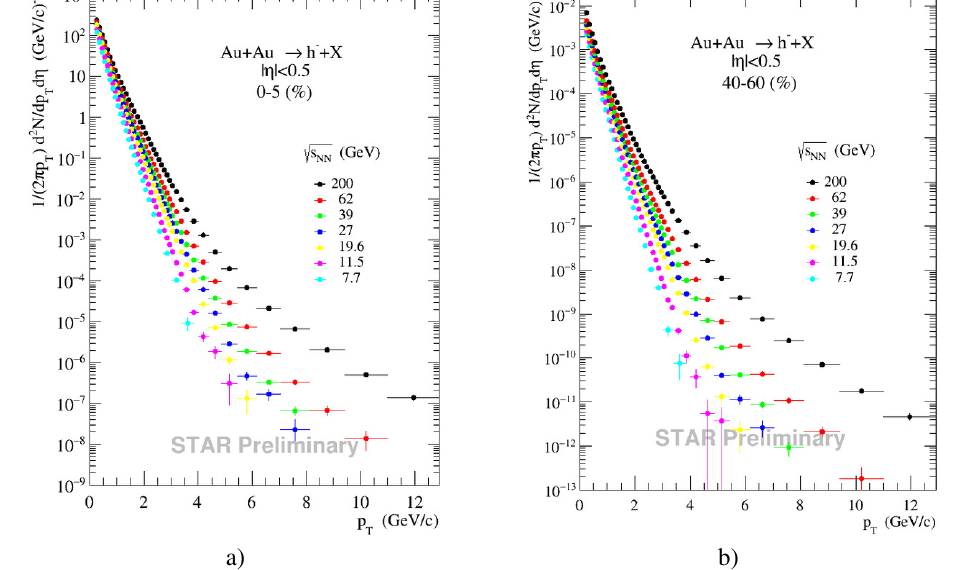
Figure 1. Inclusive spectra of negative hadrons produced in the most central (a) and peripheral (b) √ Au + Au collisions at s NN = 7 . 7 − 200 GeV and | η | < 0 . 5. The symbols correspond to the experimental data obtained by the STAR Collaboration at RHIC [5]. Error bars shown are statistical